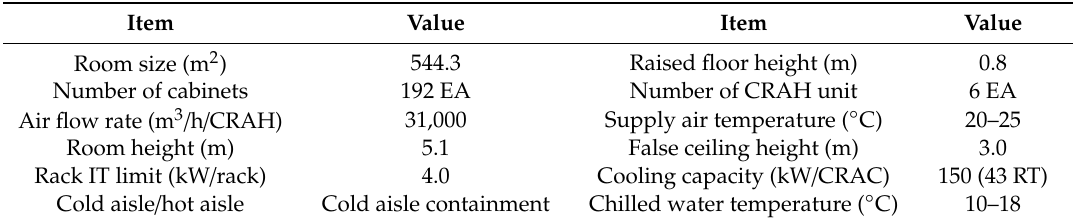
Figure 8. IT server room thermal model for computational fluid dynamics (CFD) simulation. Table 4. Simulation boundary conditions.